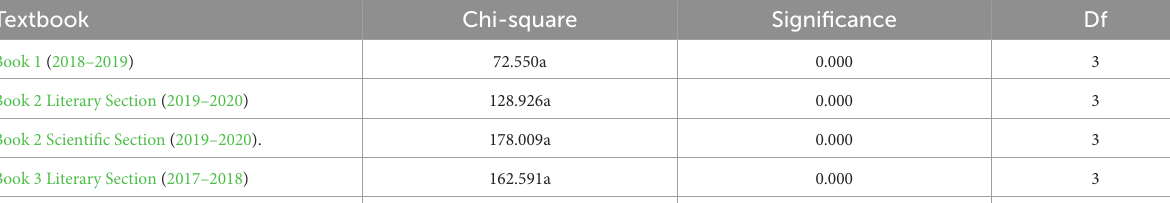
TABLE 2 Chi-square results for overall speech acts in 21st Century English for Libya secondary 1, 2, and 3 course books and workbooks. Textbook